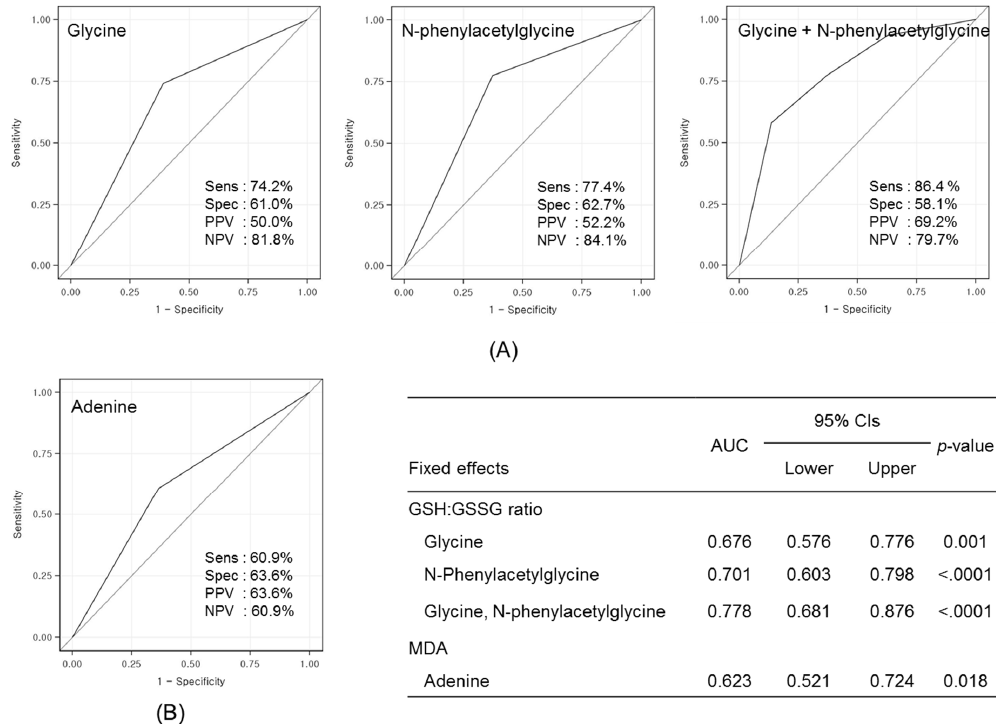
Figure 3. ROC curves of three single metabolite and a two ‐ metabolite set for predicting changes in traditional biomarkers: ( A ) erythrocyte GSH:GSSG ratio; and ( B ) plasma MDA level. The gray diagonal line represents the reference line of 0.5. Sensitivity, specificity, PPV, and NPV are shown in each box, and AUC, CI, and p ‐ value are presented in the inset. ROC, receiver operating characteristic; GSH, glutathione; GSSG, oxidized glutathione; MDA, malondialdehyde; PPV, positive predictive value; NPV, negative predictive value; AUC, area under the curve; CI, confidence intervals.